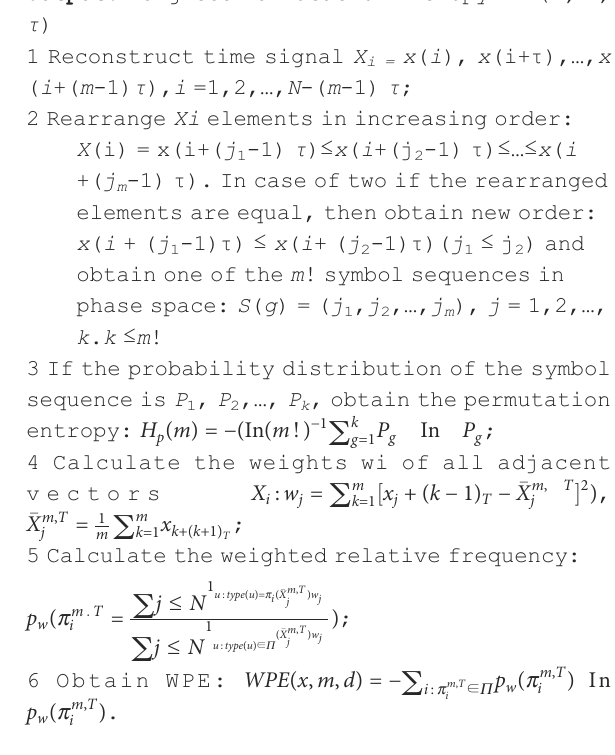
ALGORITHM3 Weighted Permutation